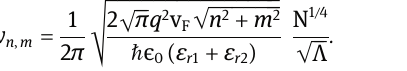
Figure 3: Grating-coupled graphene. (a) Schematic illustration of a graphene FET coated with a periodic array of Au